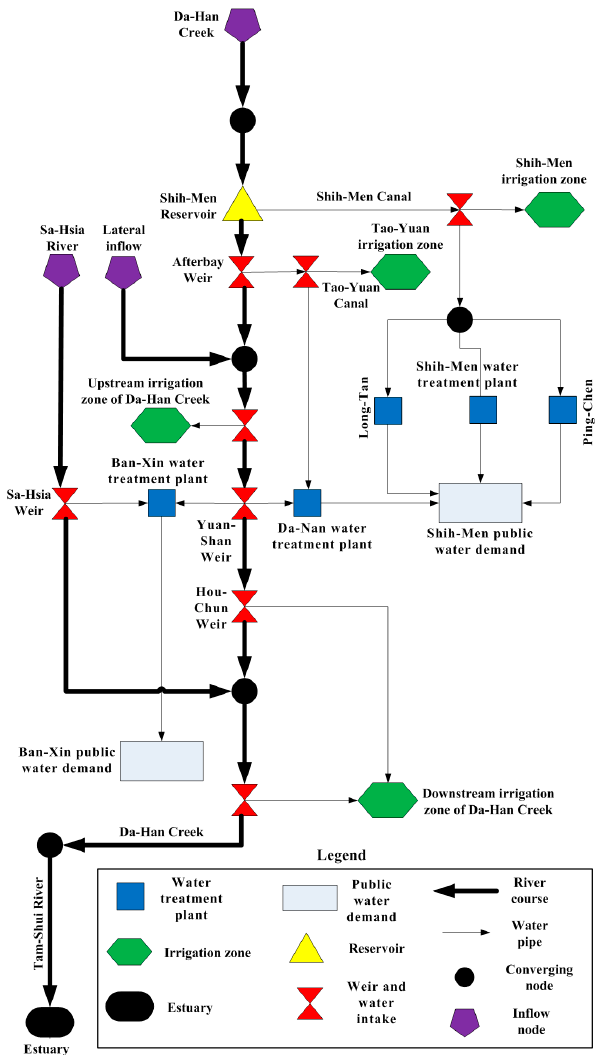
Figure 3. Water supply system for Da-Han Creek.